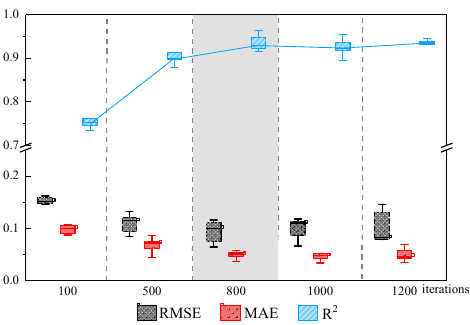
9 of 17 Figure 4. Comparison of prediction accuracy and training time of models with different augmenta- tion multiples: ( a ) stage of training; ( b ) stage of testing; ( c) time-consuming. 3.3.2. Determine the Hyperparameters of the ANN Model